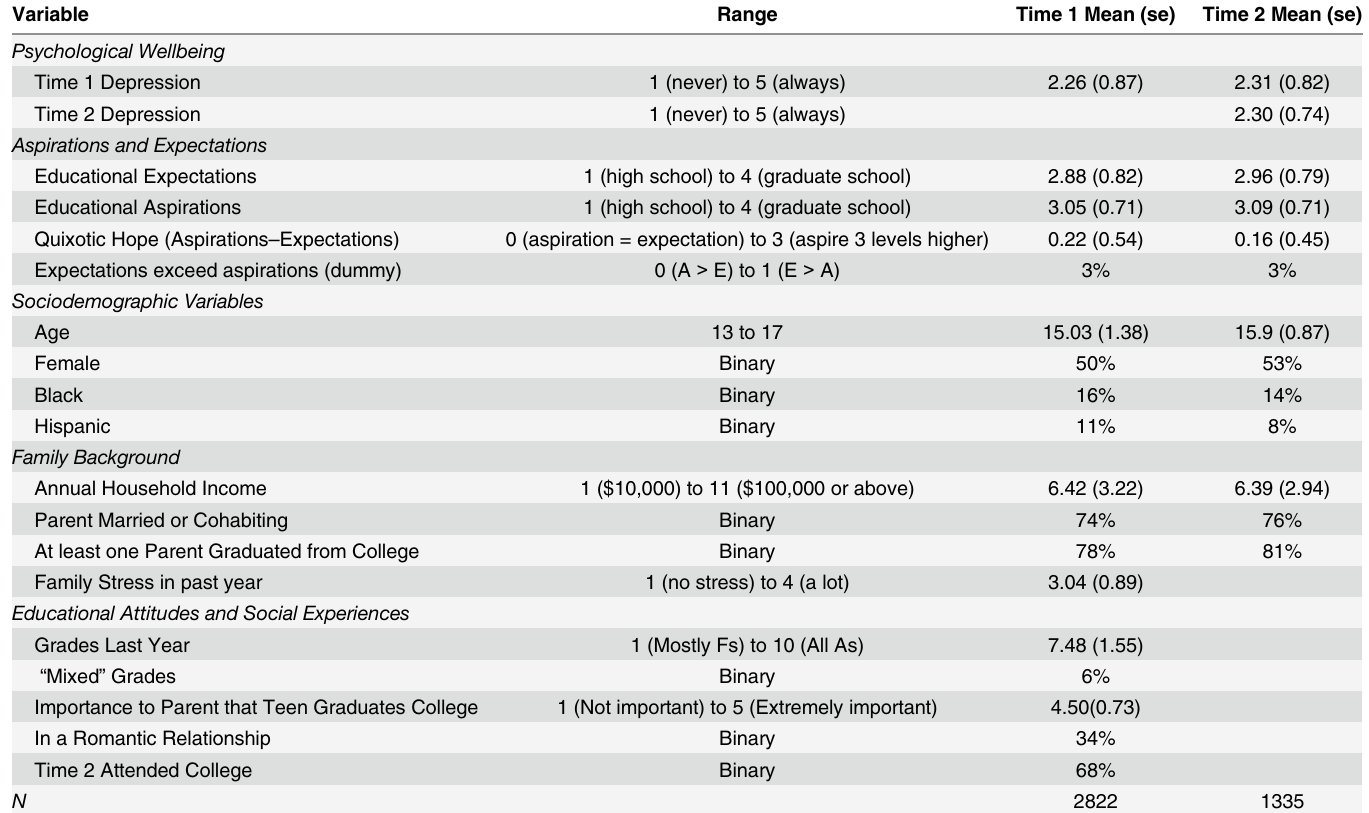
Table 4. Means and standard deviations for measures included in Study